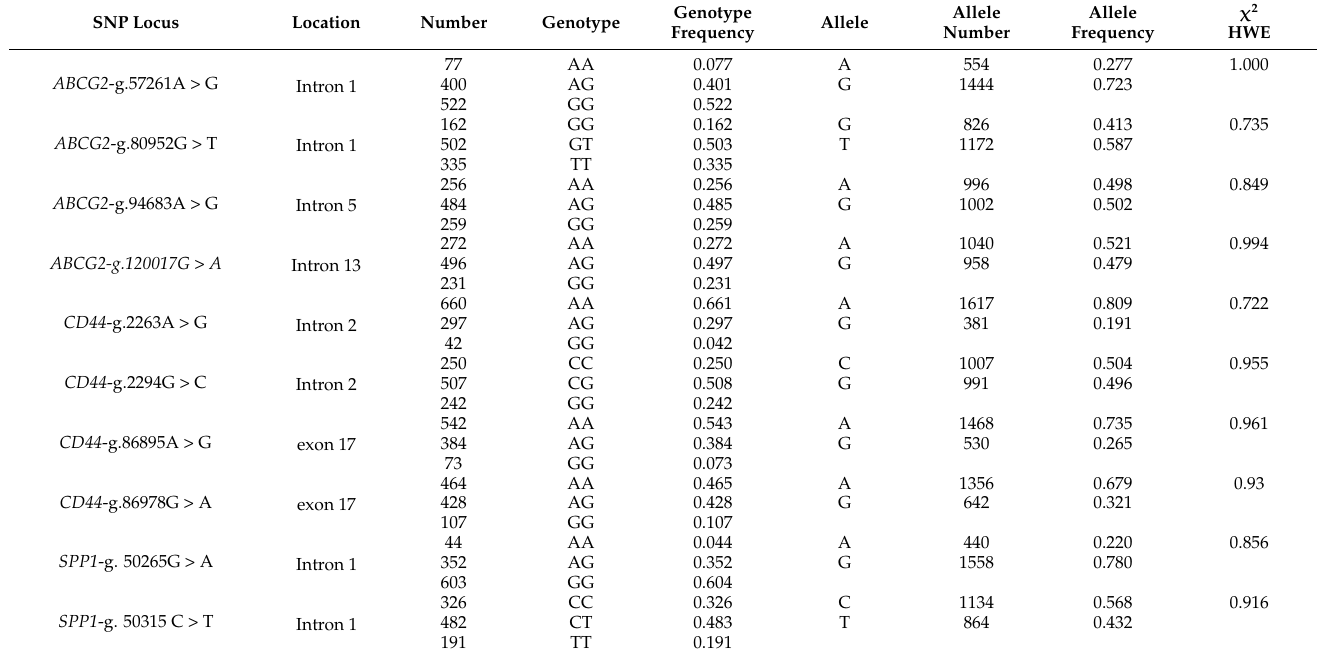
Table 3. Genotype and allele frequency of SNPs of ABCG2 , CD44 and SPP1